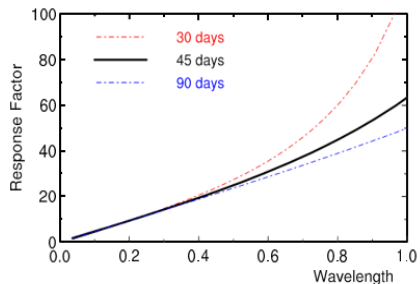
Figure A5. Response factor of the eastward travelling mode with n = −1 versus the zonal forcing wavelength (normalized by the circumference of the Earth). The red, black, and blue lines represent the forcing period 30, 45 and 90 days, respectively.